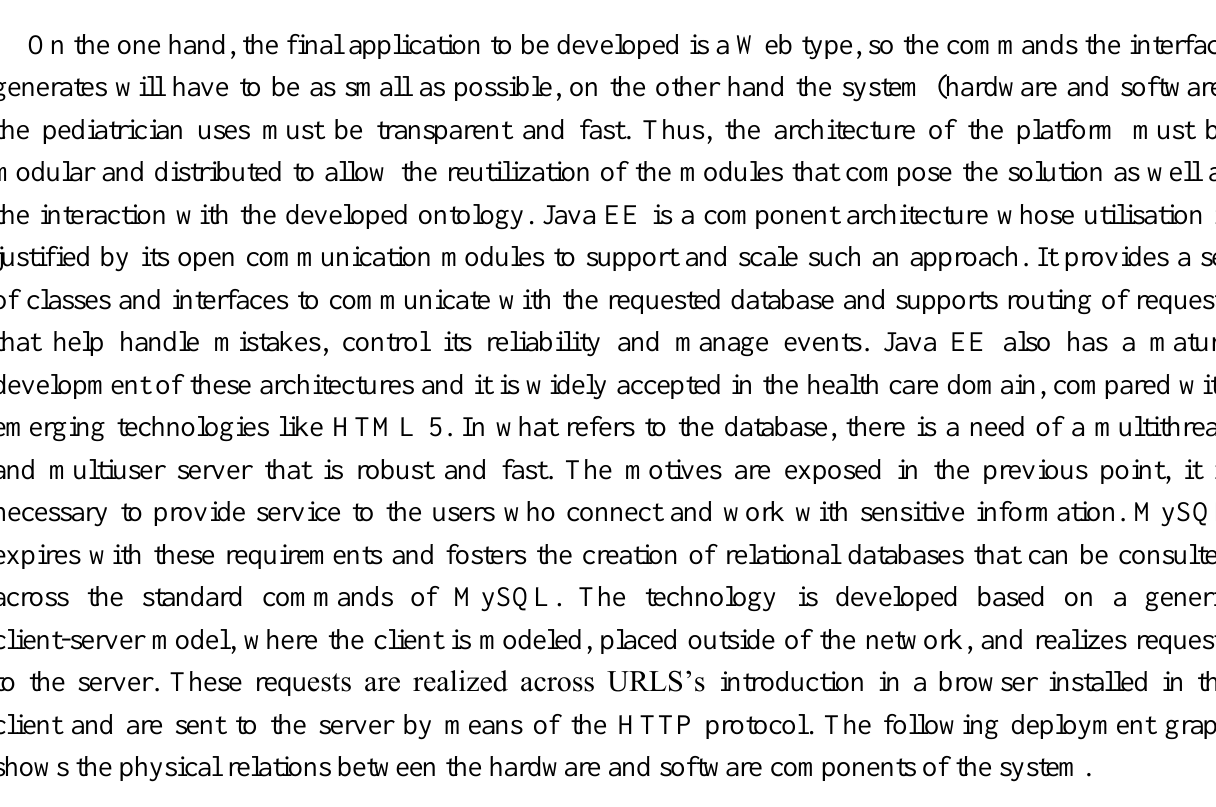
Figure 5. Inference in Protégé for questions about 2 month-old child.